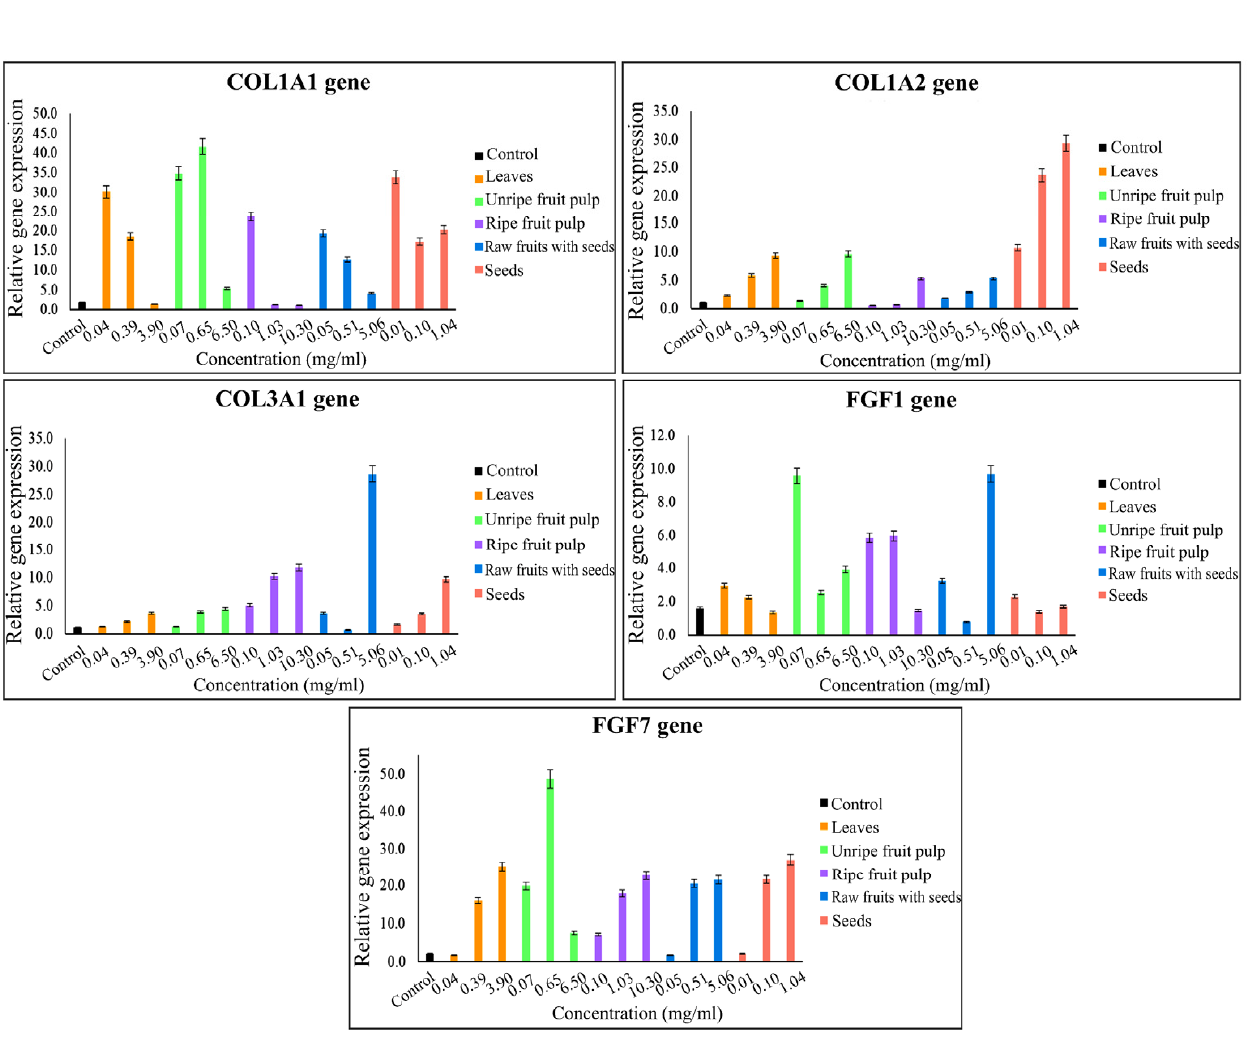
Figure 3. Graphs plotting the stimulatory gene expression value and the studied plant parts with various concentrations, showing the stimulatory effect of Morinda citrifolia (Mc) parts/extracts containing α - EG and pinoresinol.